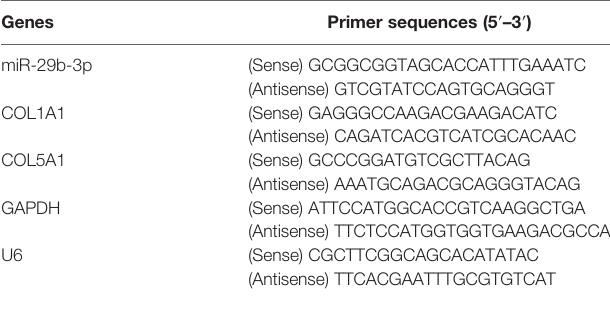
TABLE 1 | The sequences of the primers used for this study. Genes Primer sequences (5 ′ – 3 ′